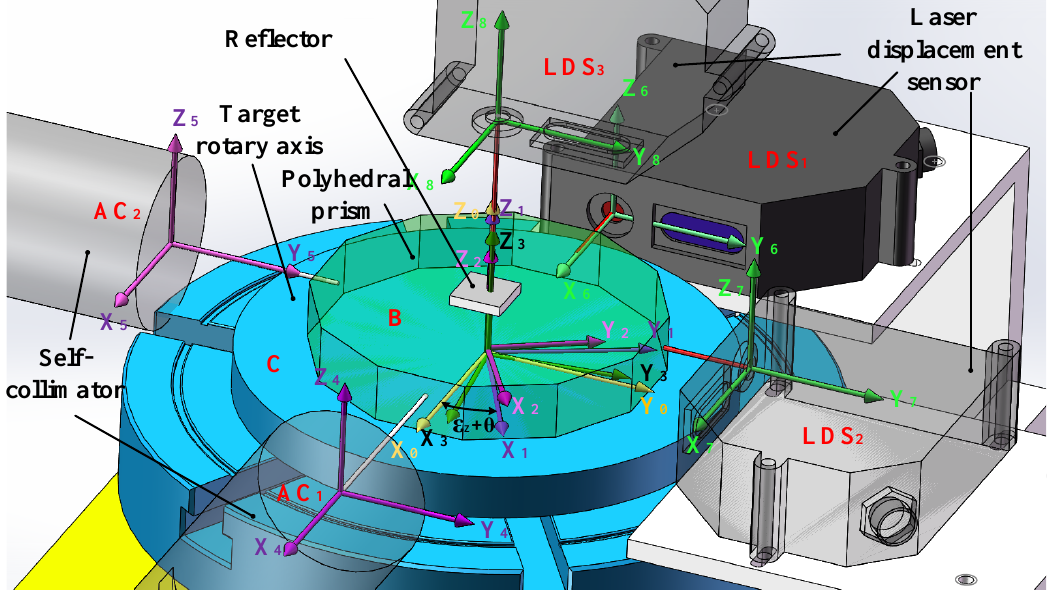
Figure 2. Schematic diagram of experimental device and coordinate system.